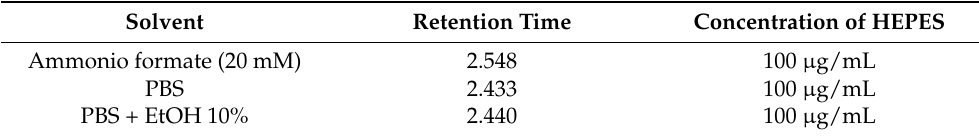
Table 1. Effect of different solvents on HEPES retention